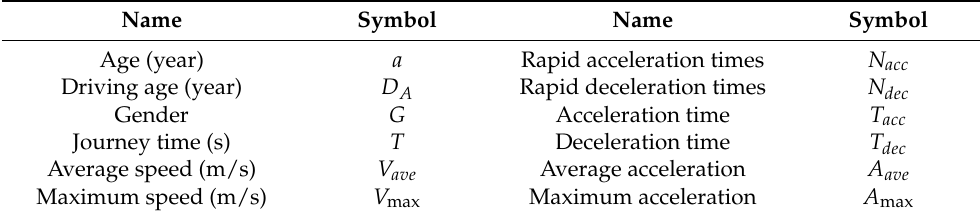
Table 5. Driving characteristic variables and representation symbols.